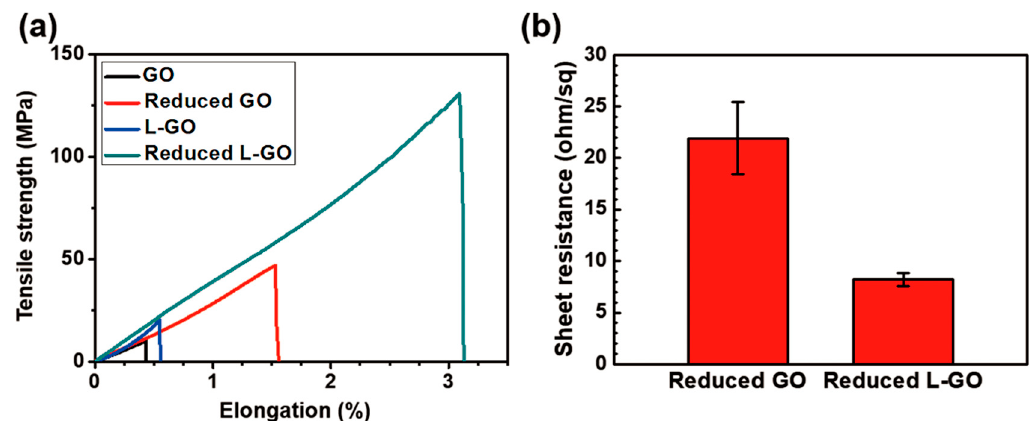
Figure 5. Mechanical strength and electronical conductivity of GO and L-GO: ( a ) strength–strain curve and ( b ) sheet resistance.